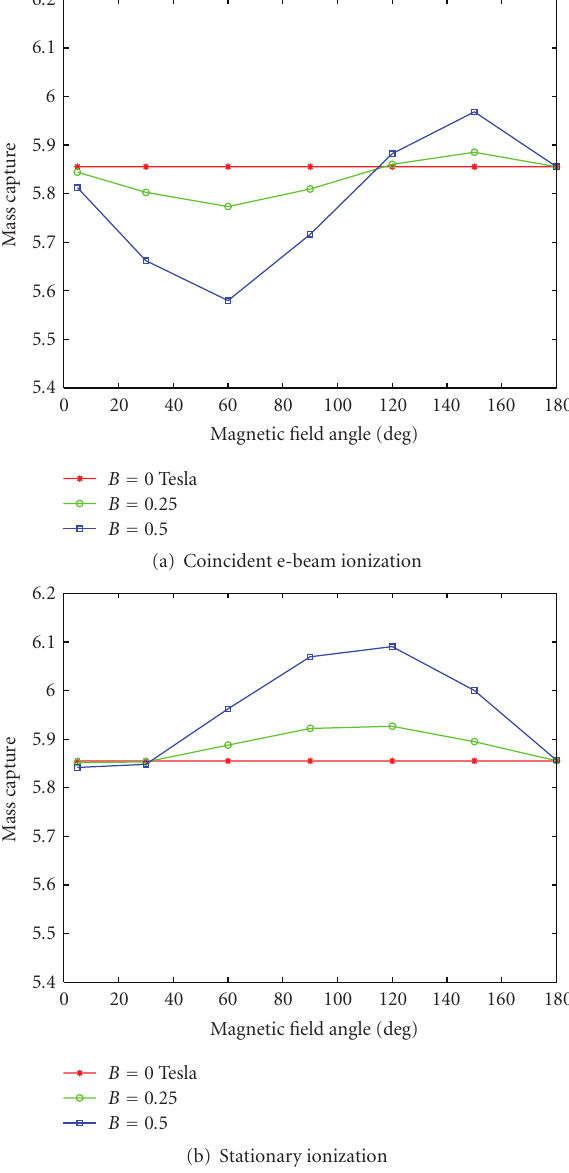
Figure 9: Mass capture for inlet with conductivity σ = 1 . 0 mho/m. Results are shown for (a) coincident ionization and (b) stationary ionization.